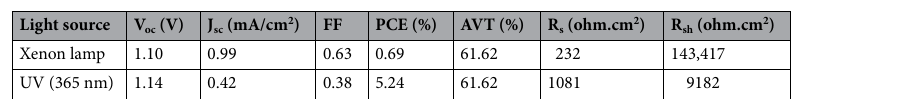
Table 3. Champion PV performances of 0.8 M, 1.5% Cs under UV-365 nm and xenon lamp